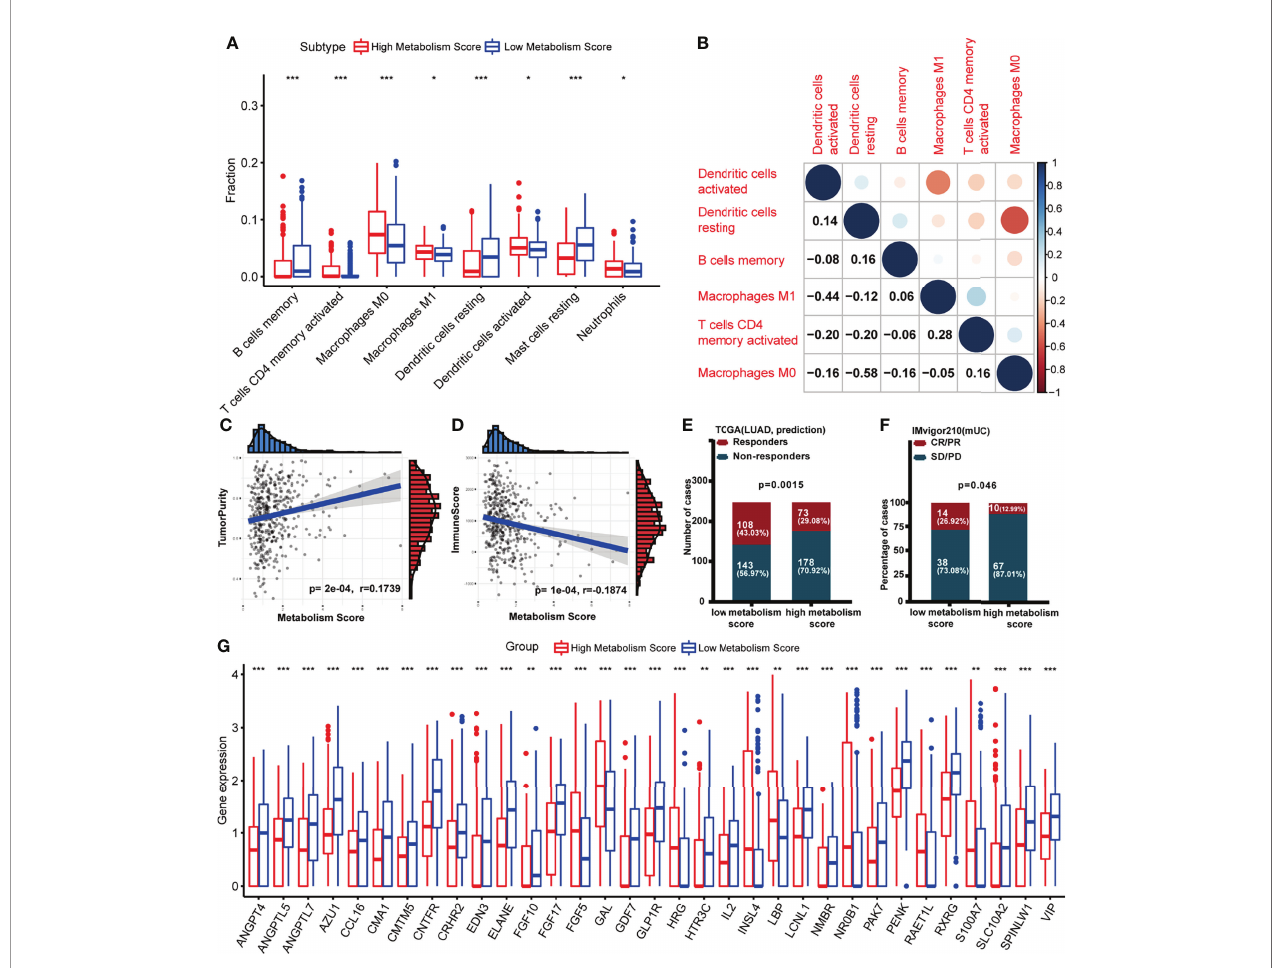
FIGURE 7 | Association between Metabolism Score and immune microenvironment. (A) Boxplot showing ratio in fi ltration differences of 8 immune cells between high- and low-Metabolism Score groups in LUAD. The Wilcoxon rank-sum test was used for the signi fi cance test. (B) The in fi ltration correlation between the above eight immune cells. (C) Correlation between tumor purity score and Metabolism Score. (D) Correlation between immune score and Metabolism Score. (E, F) Response rate to immune checkpoint inhibitors (ICIs) between high- and low-Metabolism Score groups based on TIDE scores and immune checkpoint cohort (IMvigor210). (G) Differently expressed immune-related genes (DEIRGs) in tumor environments between LUAD with high and low Metabolism Scores were mapped with boxplots. *p < 0.05, **p < 0.01 and ***p <